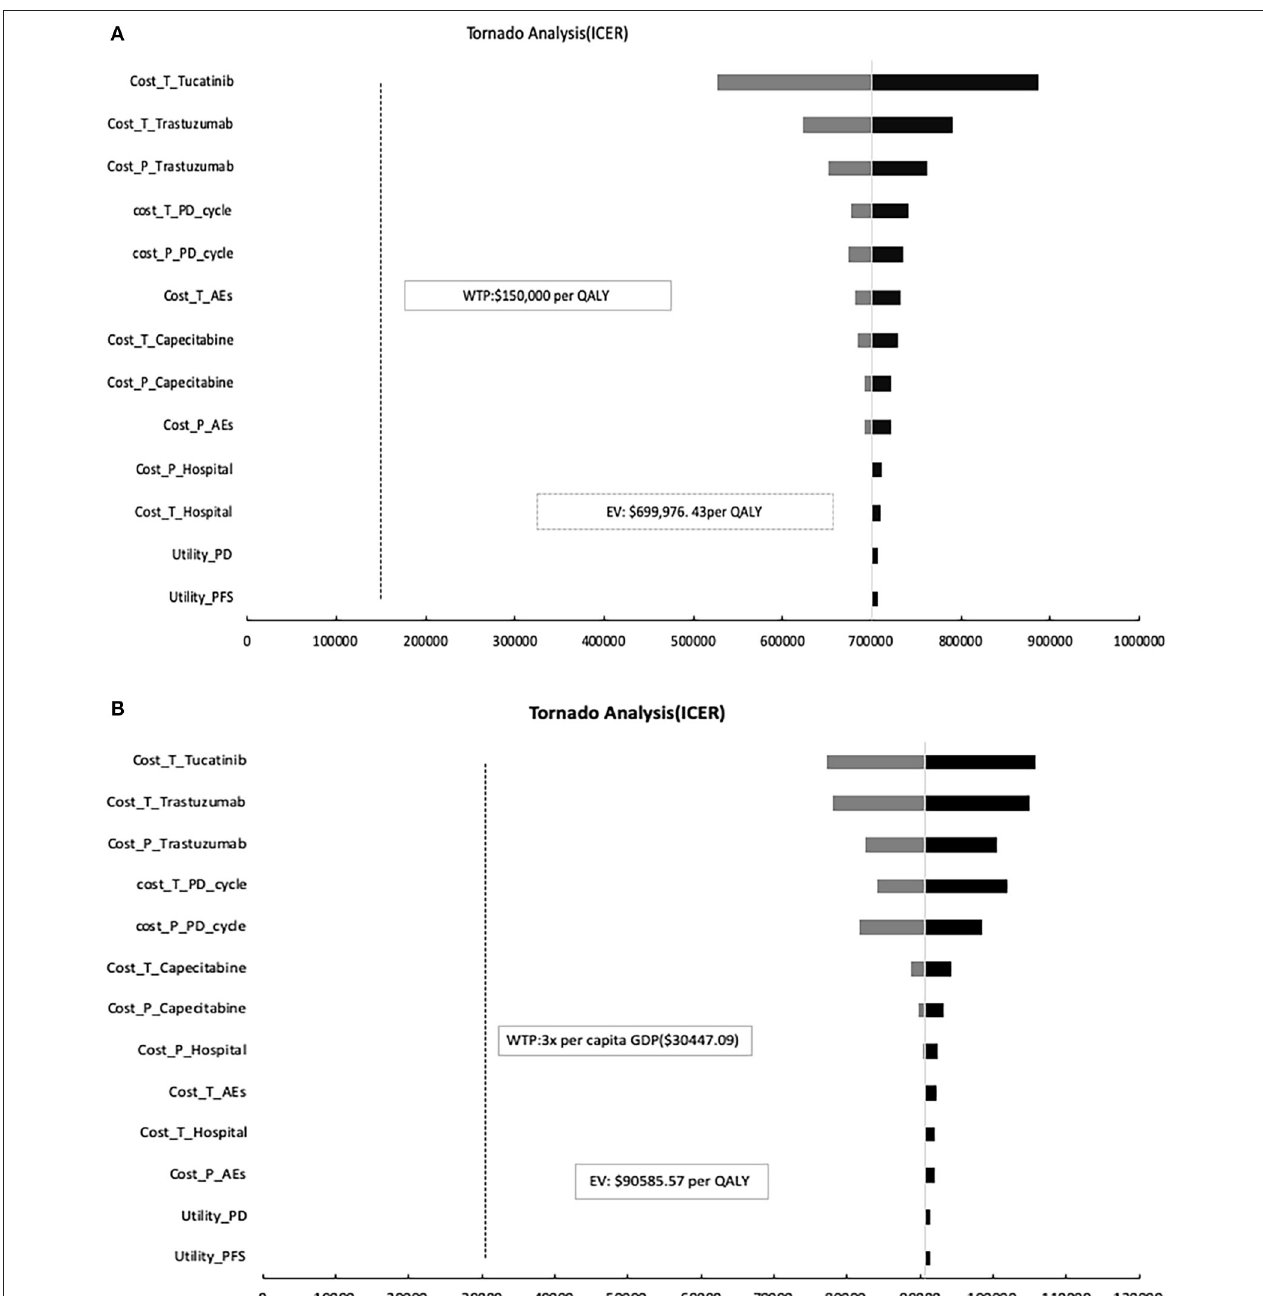
FIGURE 3 | One-way sensitivity analysis. This diagram shows the incremental cost effectiveness ratio (ICER) of TXT vs. TX for different model input parameters in the United States (A) and China (B) , respectively. TXT, tucatinib, trastuzumab, and capecitabine; TX, trastuzumab plus capecitabine; PFS, progression-free survival; PD, progression disease; AEs, adverse